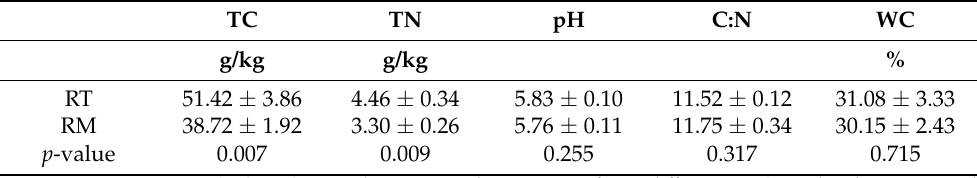
Table 1. Soil physicochemical properties in different harvesting residue treatments. TC TN pH